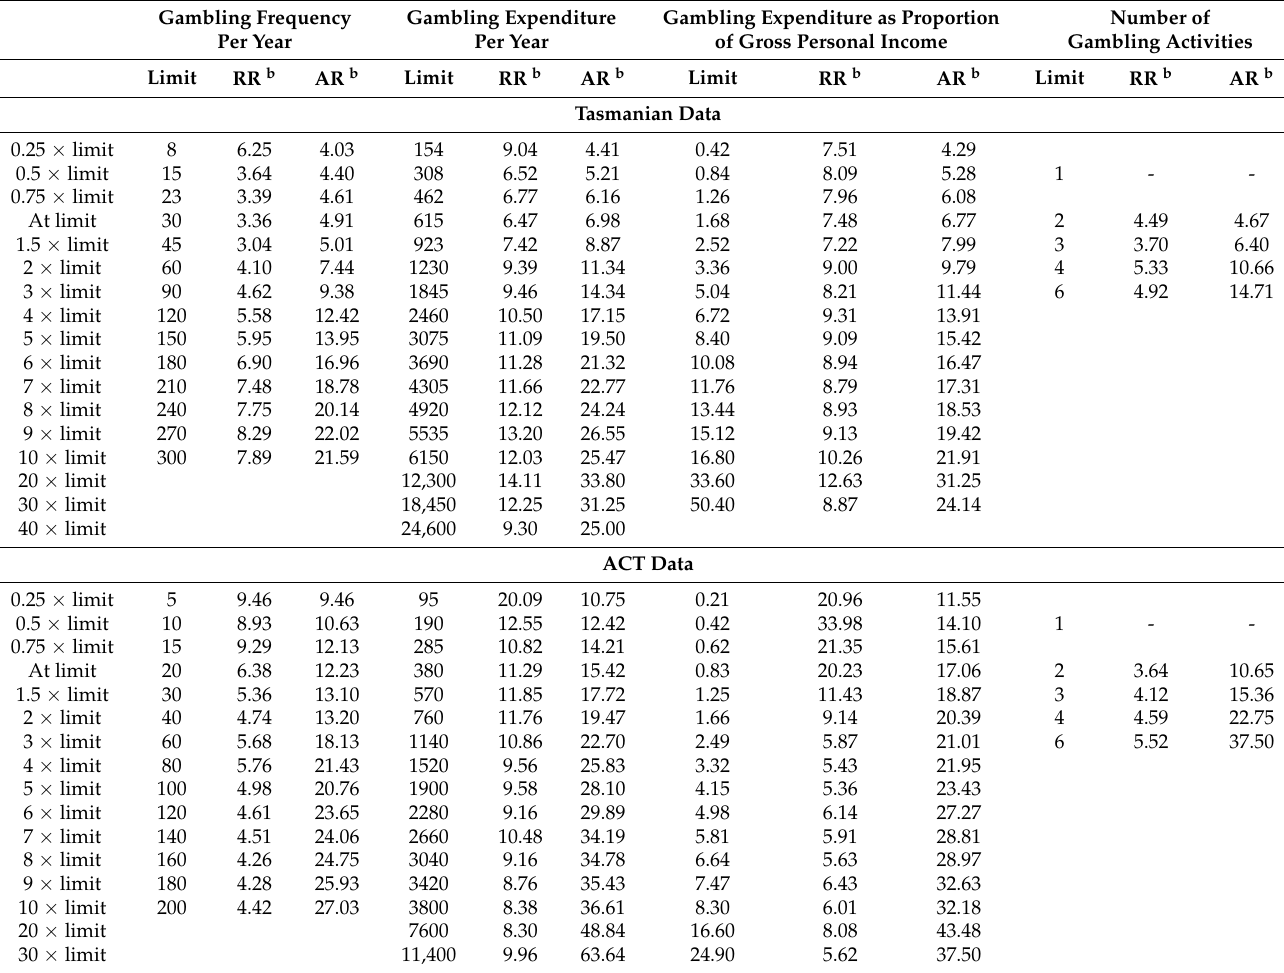
Table 4. The relative and absolute risk for gambling-related harm associated with exceeding the low-risk gambling limits a . Gambling Frequency Per Year